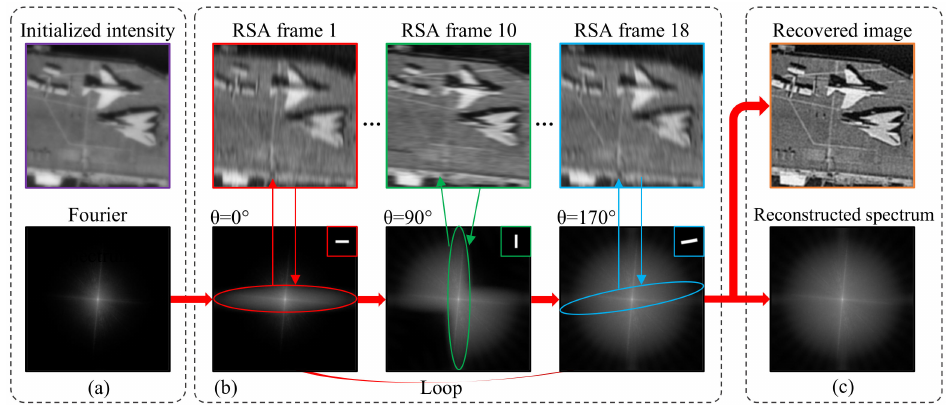
Figure 8. The Fourier spectrum restoration procedure of our algorithm. ( a ) The initial image and spectrum. ( b ) The iterative reconstruction process. The top images are degraded RRA images. The bottom images are the reconstructed spectra, and the top right inset images are the corresponding aperture patterns. The red, green, and blue ellipses show the areas of influence of the corresponding frames. ( c ) Iteratively reconstructed result.